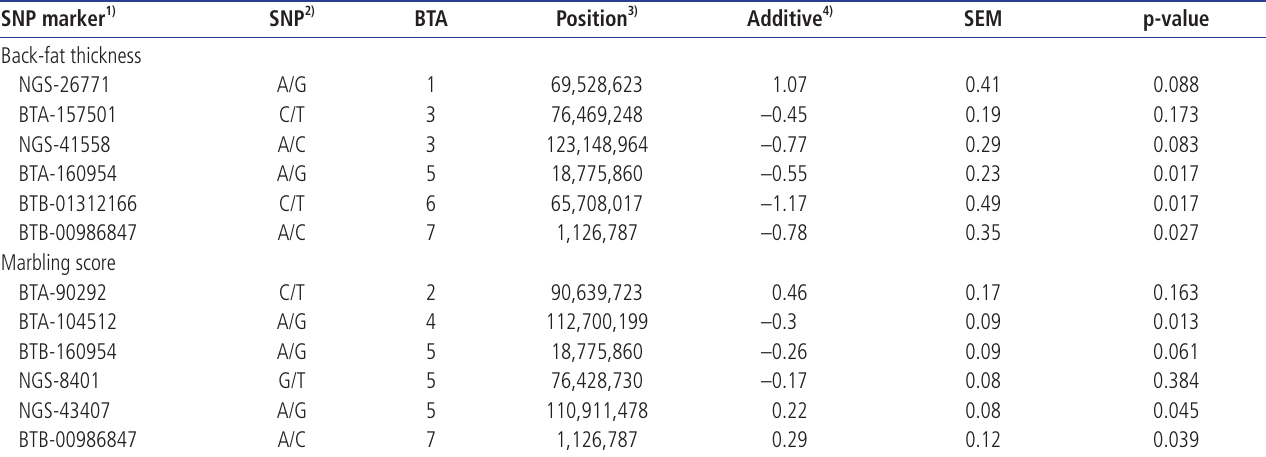
Table 8. Identities, positions, and effect of the SNPs on back fat thickness and marbling score of Hanwoo steers SNP marker